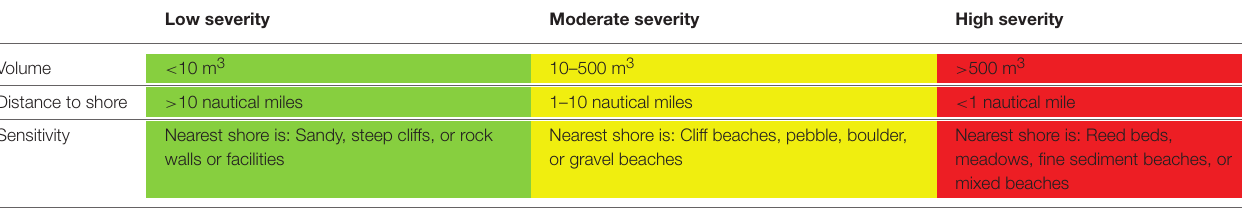
TABLE 1 | Matrix for Tier 2 consequence assessment in